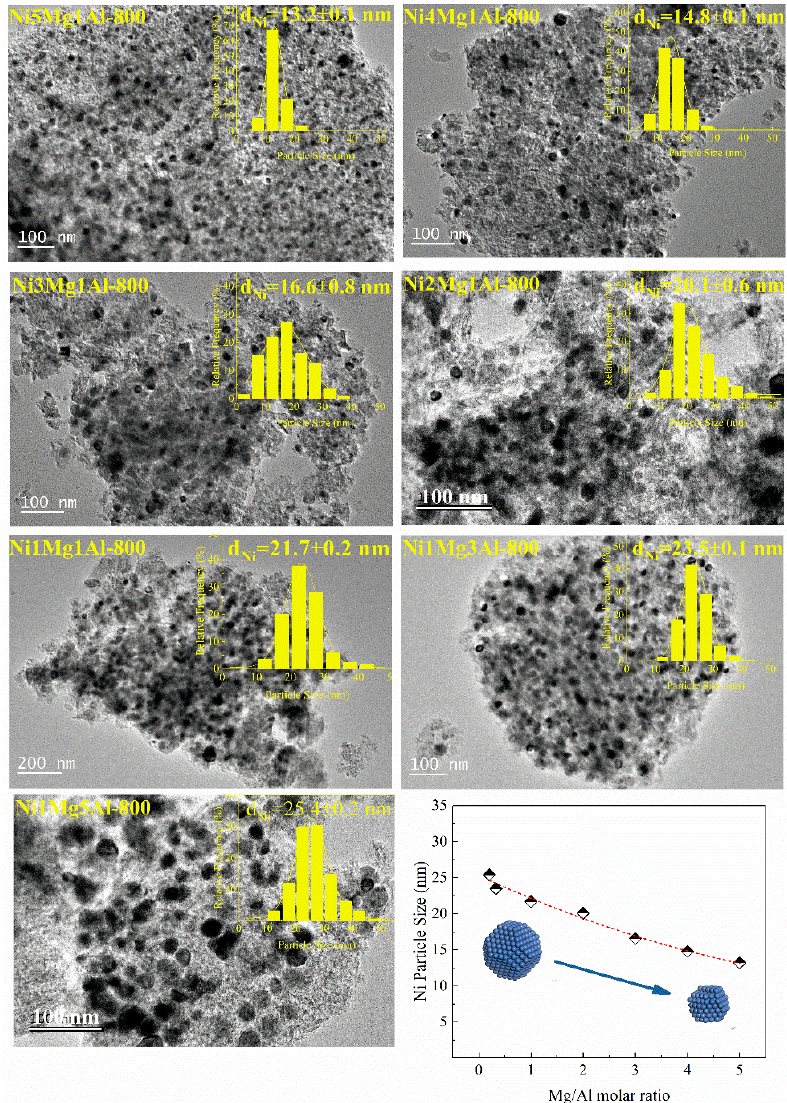
Figure 3. TEM images and particle size distribution for the reduced Ni x Mg y Al-800 catalysts.